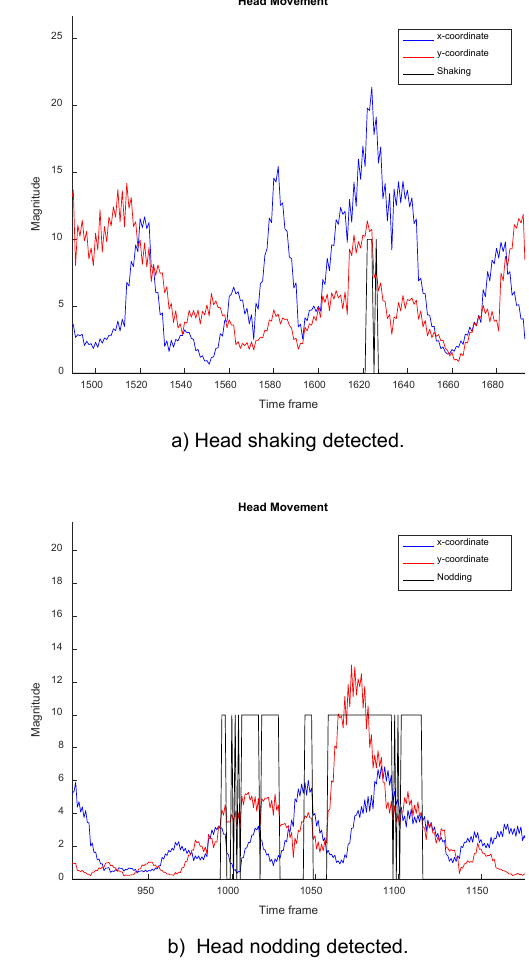
Figure 5 | Head movement